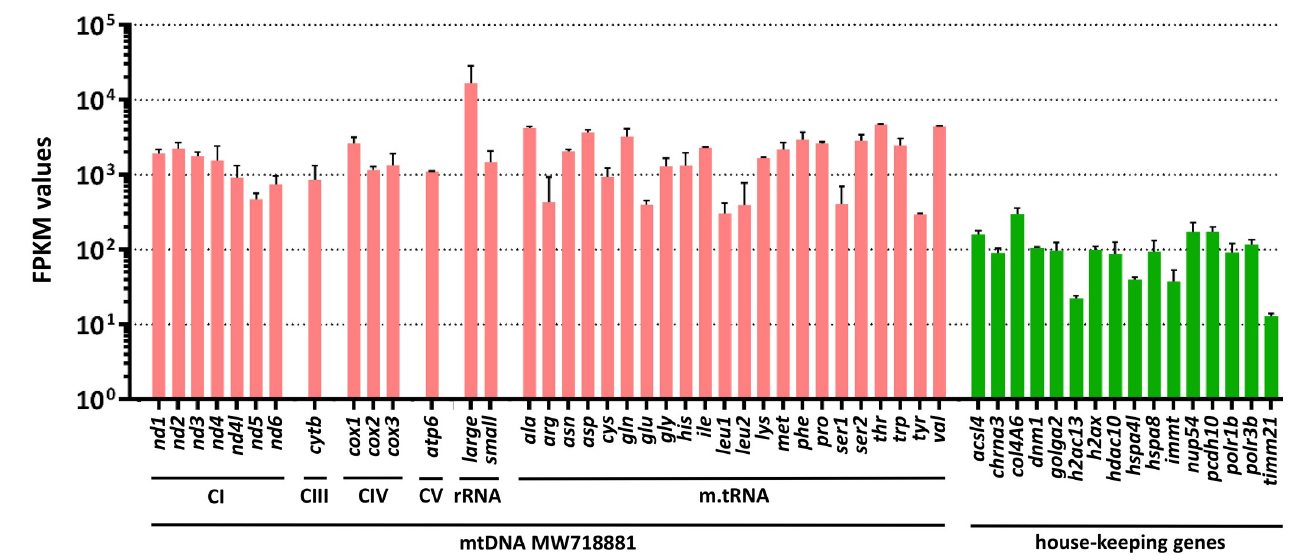
Fig 6. mRNA gene expression in Taenia solium eggs. The bars depict the FPKM values (fragments per kilobase of exon per million reads mapped) of mitochondrial (mtRNA, pink) and nuclear (nRNA, green) encoded house-keeping genes in single T . solium eggs. The expression levels of worm mtDNA encoded genes are on average 10–100 fold higher than that of nuclear encoded house-keeping genes. The mtDNA encoded genes are sorted according to their coding function for subunits of respiratory chain complex I (CI), complex III (CIII), cytochrome C oxidase (CIV), ATPase (CV), the large and small fragments of the mitochondrial ribosomal RNA (rRNA), and the mitochondrial transfer-RNAs (m.tRNA). The bars depict the mean and SD of two biological replicates. acsl4 , acyl-CoA synthetase long chain family member 4 (TsM_000719800); chrna3 , cholinergic receptor nicotinic alpha 3 subunit (TsM_000436900); col4a6 , collagen type IV alpha 6 chain (TsM_000925000); dmn1 , dynamin 1 (TsM_000700600); golga2 , golgin A2 (TsM_000292400); h2ac13 , H2A clustered histone 13 (TsM_000346300); h2ax , H2A.X variant histone (TsM_000426400); hdac10 , histone deacetylase 10 (TsM_000886700); hspa4l , heat shock protein family A (Hsp70) member 4 like (TsM_000256500); hspa8 , Heat shock protein family A (Hsp70) member 8 (TsM_000375700); immt , Inner membrane mitochondrial protein (TsM_000168900); nup54 , Nucleoporin 54 (TsM_000540600); pcdh10 , Protocadherin 10 (TsM_000478100); polr1b , RNA polymerase I subunit B (TsM_000754600); polr3b , RNA polymerase III subunit B (TsM_000691900); timm21 , Translocase of inner mitochondrial membrane 21 (TsM_001020500), the accession numbers in brackets refer to the transcripts from the PRJNA170813 BioProject [30]. Nota bene , due to the large expression differences we opted for a logarithmic rendition of FPKM values.